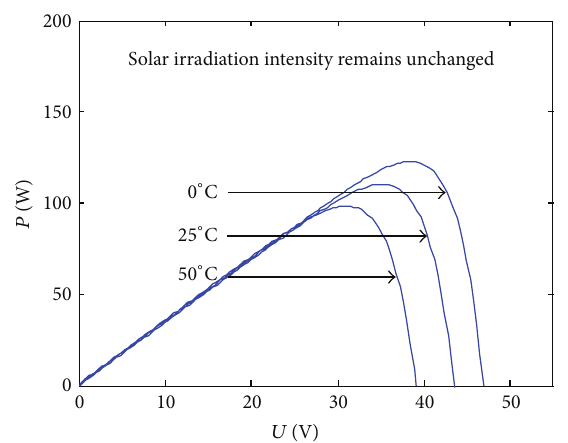
Figure 5: 𝑃 - 𝑈 characteristic curves of PV cell at different